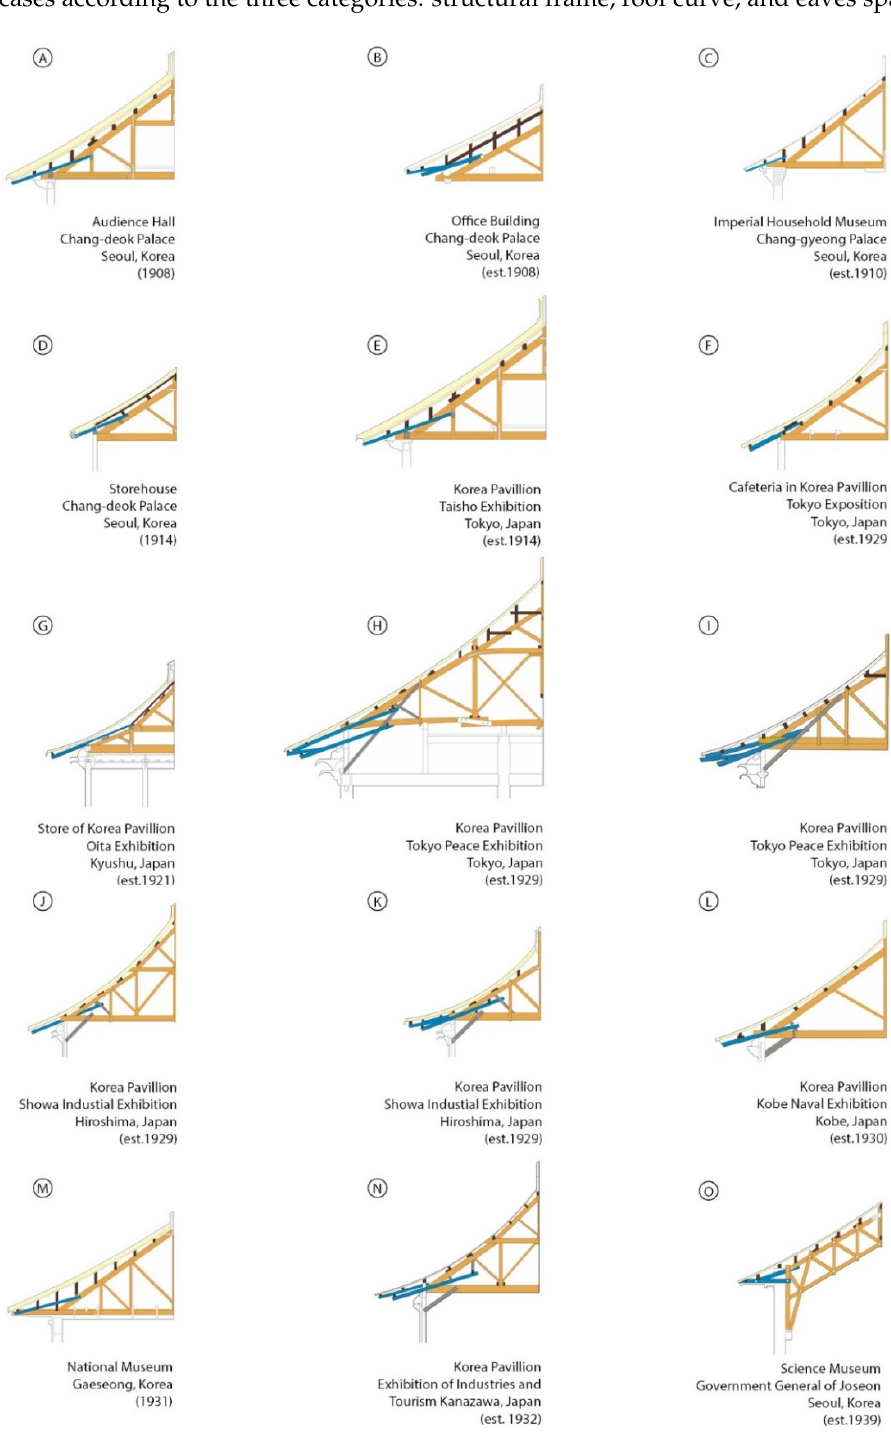
Figure 14. Analytic Drawing of 15 Cases Focusing on Structural Frame, Roof Curve, and Eaves Space (In the Chronological Order) (Source: ( A – D ) Jangseogak Royal Archives, ( E – O ) National Archives of Korea).